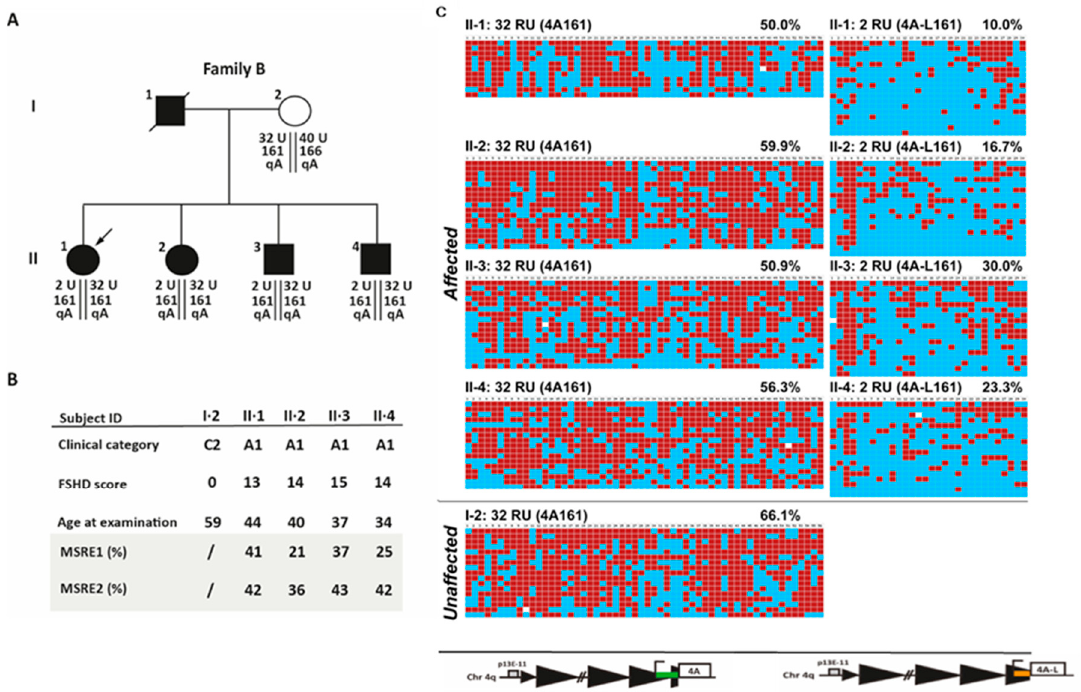
Figure 7. Analysis of the D4Z4 methylation status B. ( A ) Pedigree of family B. The genetic profile ( A ) or the clinical and epigenetic features ( B ) of each individual are reported. Filled symbols represent affected people ( C ) Genomic DNAs from the selected individuals were analyzed using the 4qA BSS assay. The percentage of DNA methylation for the Q1 is indicated. Red boxes indicate methylated CpGs, blue boxes indicate unmethylated CpGs, and white boxes indicate no CpG at the expected site.